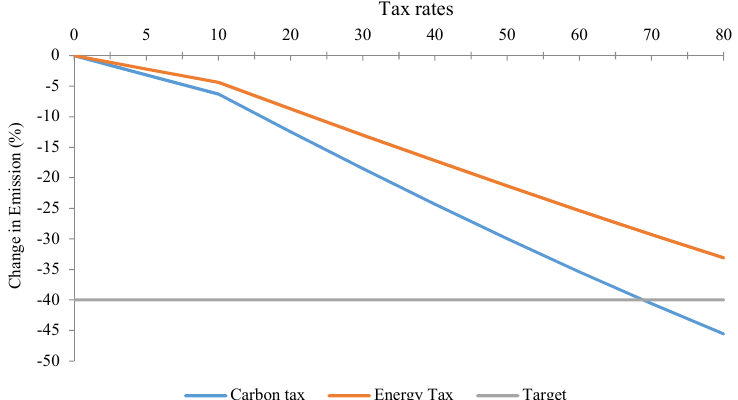
Fig. 5: Changes in emissions due to climate change policies at different tax levels - 0 to 80 $ per ton of CO 2; compared to the Copenhagen target CO 2